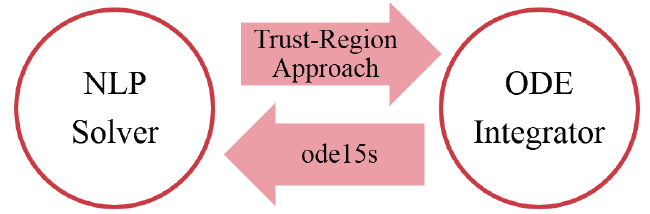
Figure 3. Algorithm for parameter estimation used to optimize model parameters. An optimization algorithm is applied in an outer loop, while the evaluation of the objective function and its gradients are performed by numerical integration of the ODEs in the inner loop. fmincon (MATLAB function) is used as the NLP (non-linear programming) solver and ode15s (MATLAB function) is used as the ODE